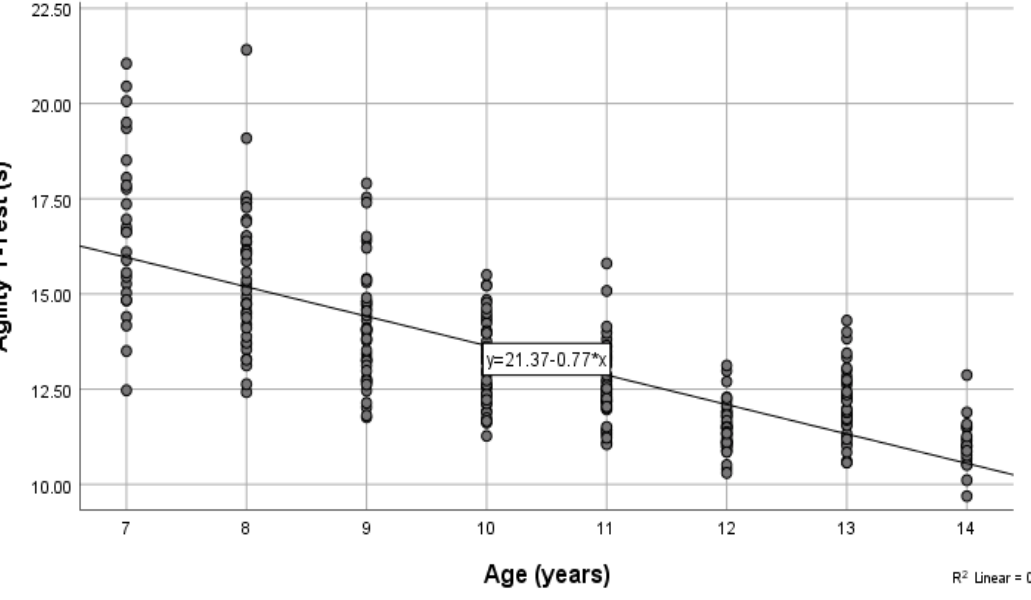
Figure 2. A scatter plot and the corresponding regression line for the relationship between the dependent variable, agility t -test (s), and the independent variable chronological age (years).